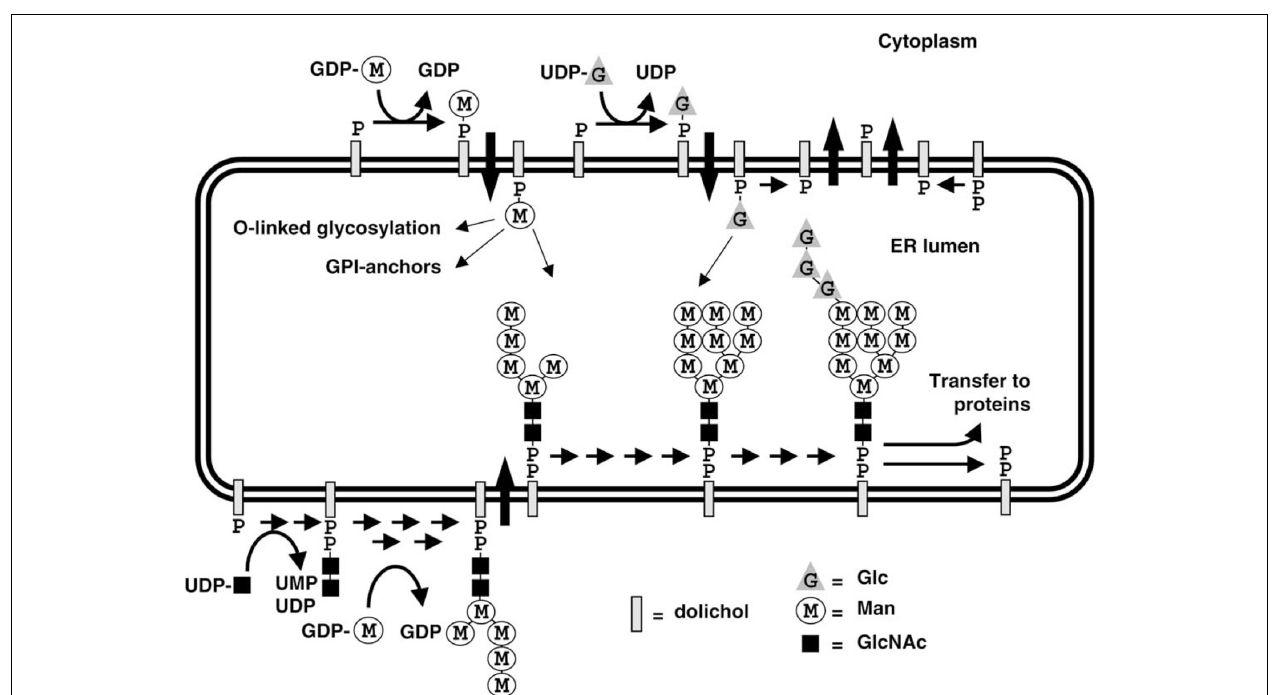
FIGURE 9 |The N -glycosylation pathway (Helenius andAebi, 2002).